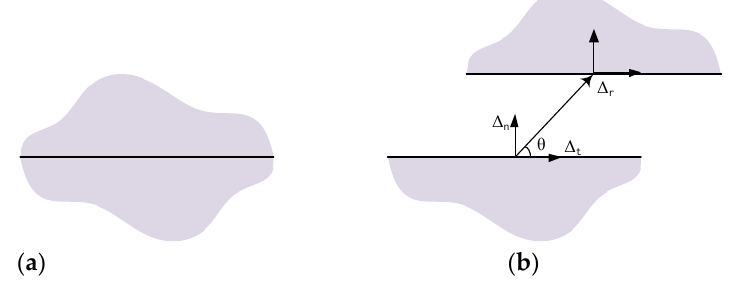
∆ r ) with the separation angle ( θ ). Before separation ( a ); after